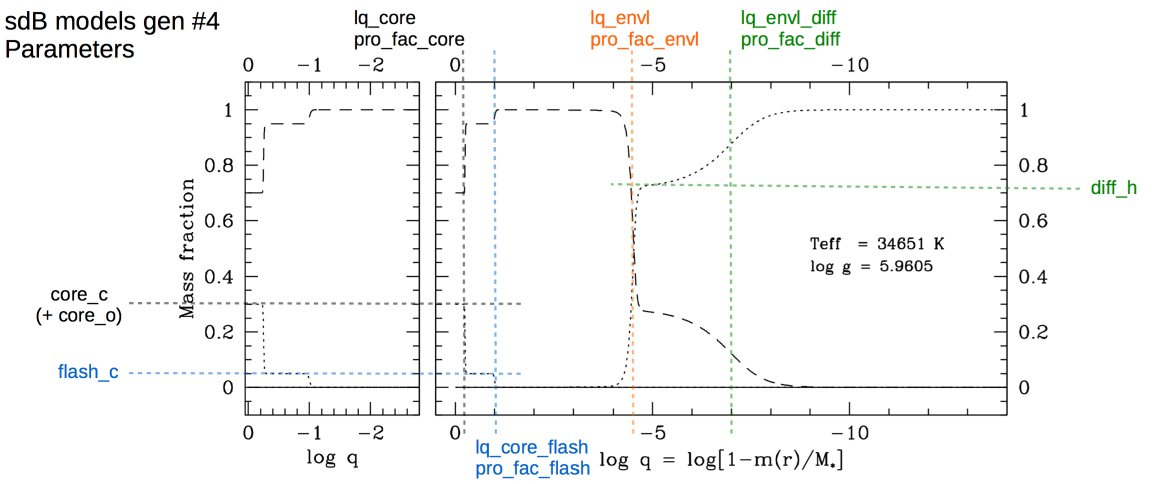
Figure 4. Parameters for the 4G sdB models.